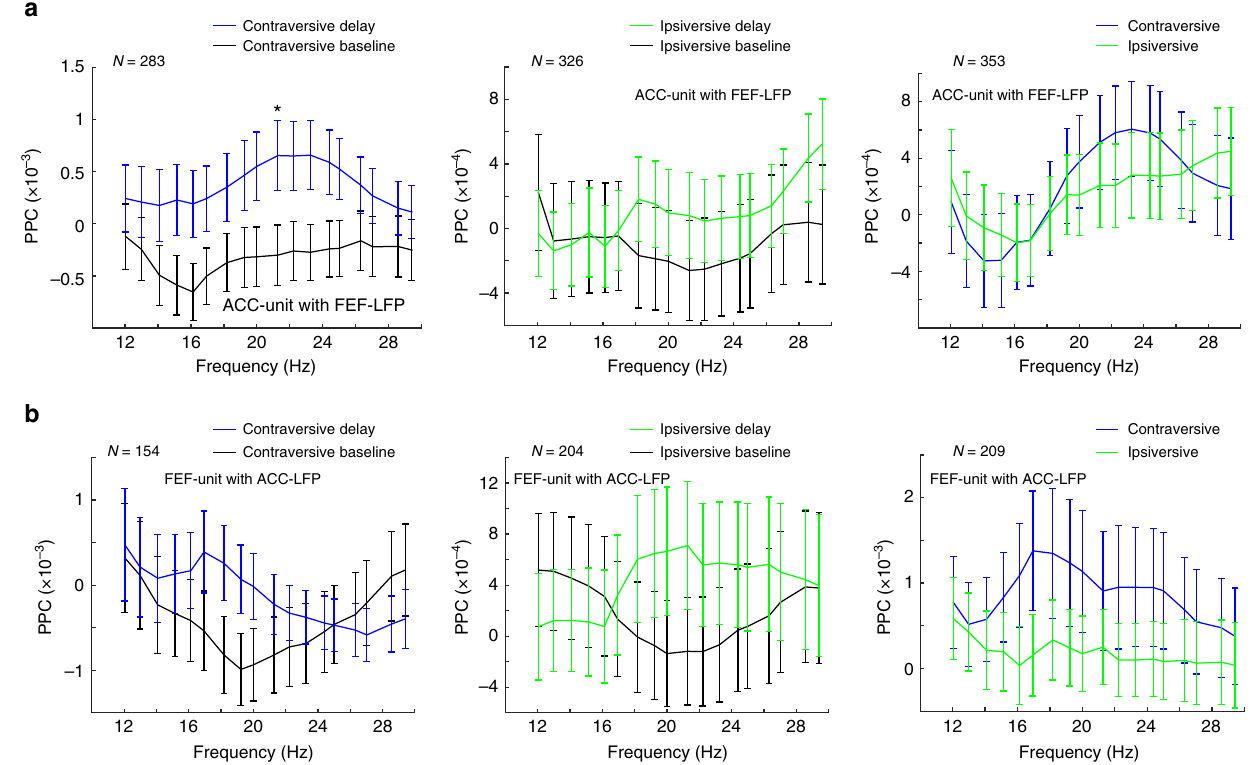
Figure 7 | Pairwise phase consistencies (PPCs) across beta band. ( a ) PPC spike-field coherence spectrum of the population of the ACC-unit with FEF-LFP pairs across the beta frequency range. Comparison between baseline and delay of contraversive saccades (left), comparison between baseline and delay of ipsiversive saccades (middle), and comparison between the contra- and ipsi-versive saccades in the delay period (right). ( b ) PPC spike-field coherence spectrum of the population of the FEF-unit with ACC-LFP pairs across the beta frequency range. Comparison between baseline and delay of contraversive saccades (left), comparison between baseline and delay of ipsiversive saccades (middle), and comparison between the contra- and ipsiversive saccades in the delay period (right). Error bars denote s.e.m. in all panels. * P o 0.05, paired t